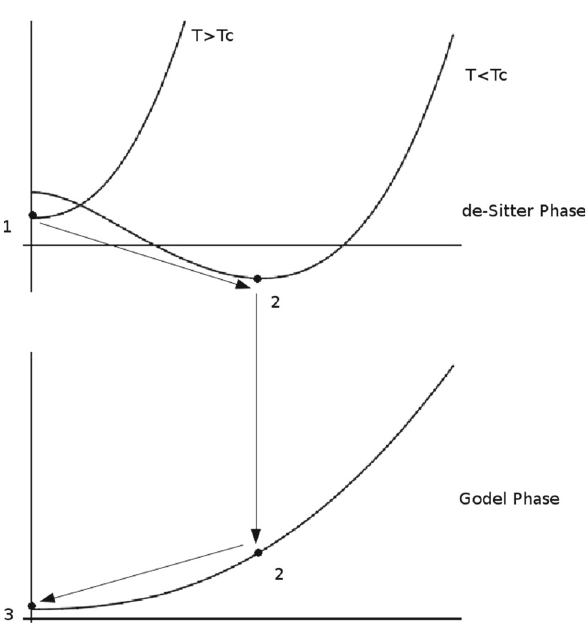
Fig. 6 AtypicalscenariooftheuniversegoingthroughdeSitter,Gödel and de Sitter phases. See [10] Fig. 7 Simulation of the induced